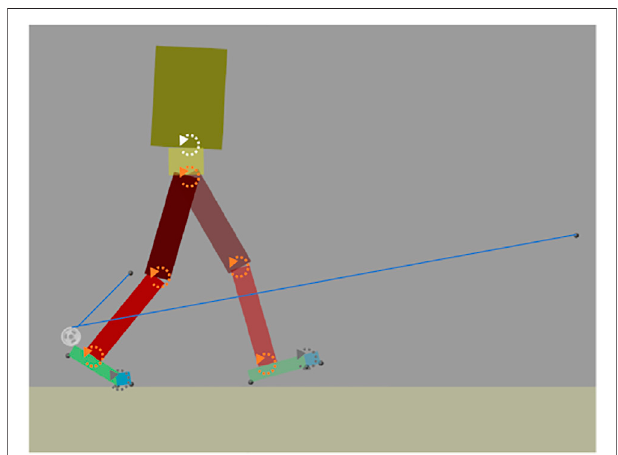
FIGURE 3 | A 2D dynamic walking model for investigating the effects of AN-EXTRA-Push on gait. AN-EXTRA-Push is worn on the right leg — the trailing leg in the pricture. Arrows mark the positions of rotary joints. Gray arrows: passive metatarsophalanegal joints; white arrow: controlled but notoptimizedlumbo-sacraljoint;orangearrows:jointssubjecttooptimization. Hip joints for both legs